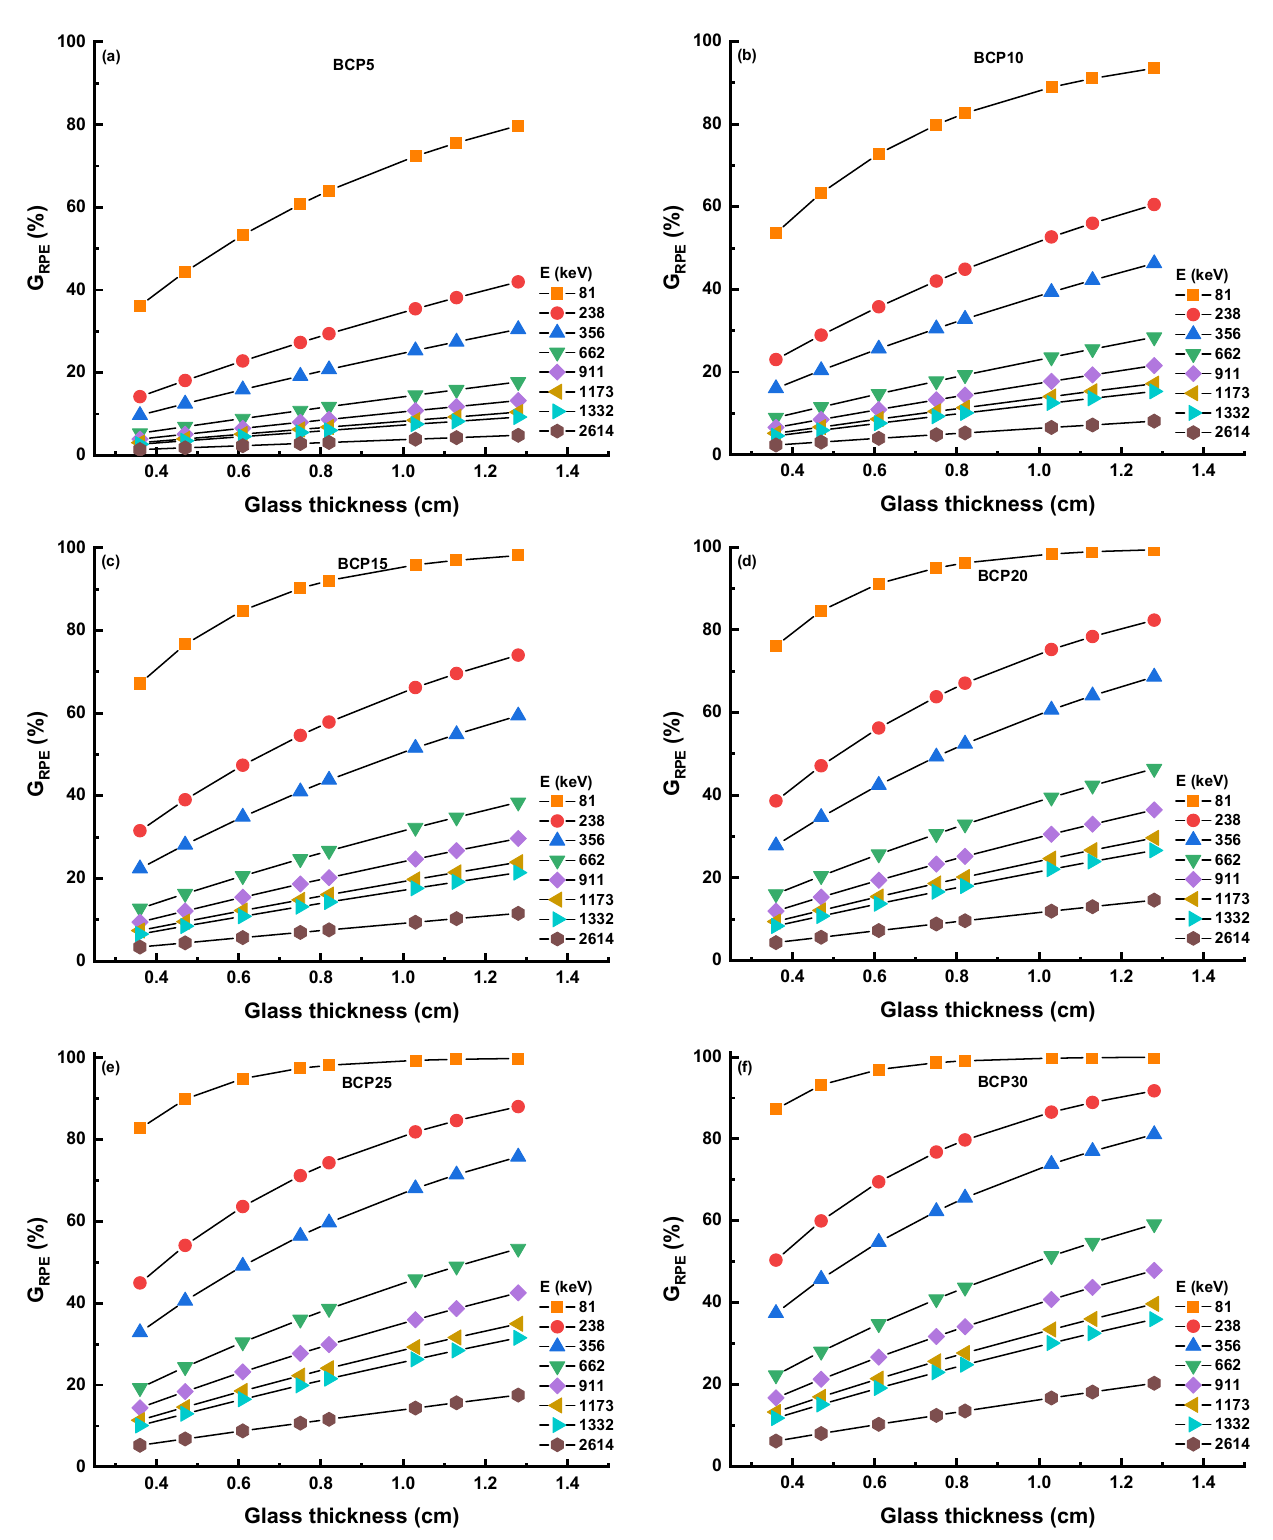
Figure 9. ( a – f ) Gamma radiation protection efficiency (G RPE ) for all glasses at selected photon energy.